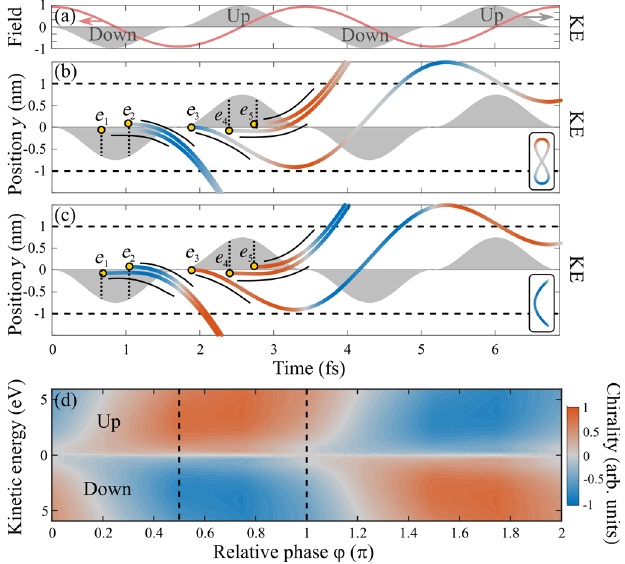
FIG. 5. Subcycle control over the instantaneous chirality of the field. (a) Oscillation of the fundamental electric field (red) and final kinetic energy of the electrons as a function of their ionization time (gray). The kinetic energy is plotted as a positive value for electrons with an upwards final velocity and as negative for electrons with a final downwards velocity, in order to differentiate between electrons reaching each half of the detector. (b),(c) Two pairs of electron trajectories ( e 1 ; 2 and e 4 ; 5 ), each pair leading to the same final kinetic energy, and a trajectory of a low- energy electron ( e 3 ). The trajectories are plotted for φ ¼ π = 2 (b) and φ ¼ π (c). The color map depicts the instantaneous chirality of the field. (d) Instantaneous chirality integrated over the time duration in which each electron is closer than 1 nm to the molecular core versus two-color phase and final kinetic energy of the